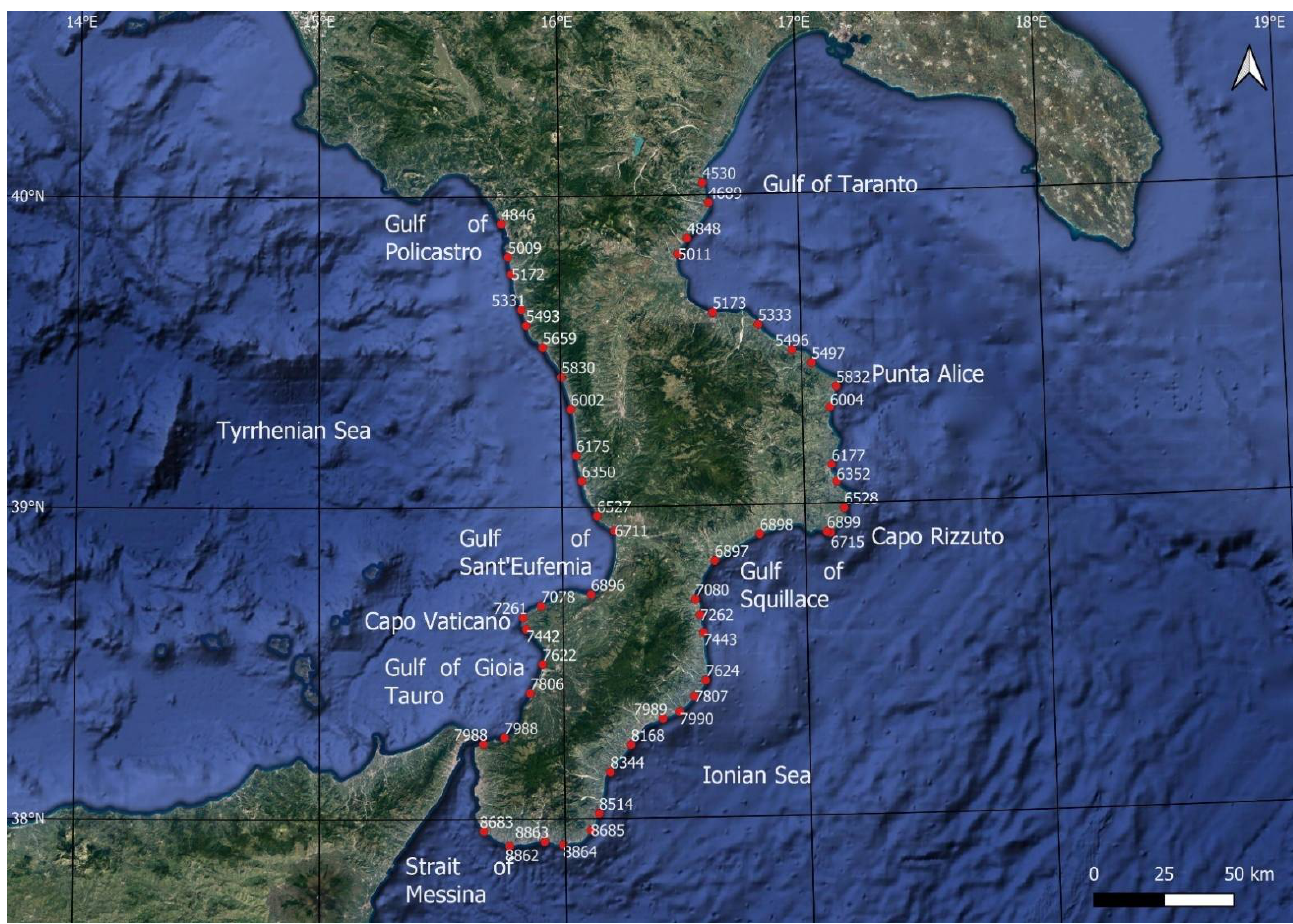
Figure 2. Calabrian sample areas, identified with a code. The names of the sample areas are shown in Table 1.